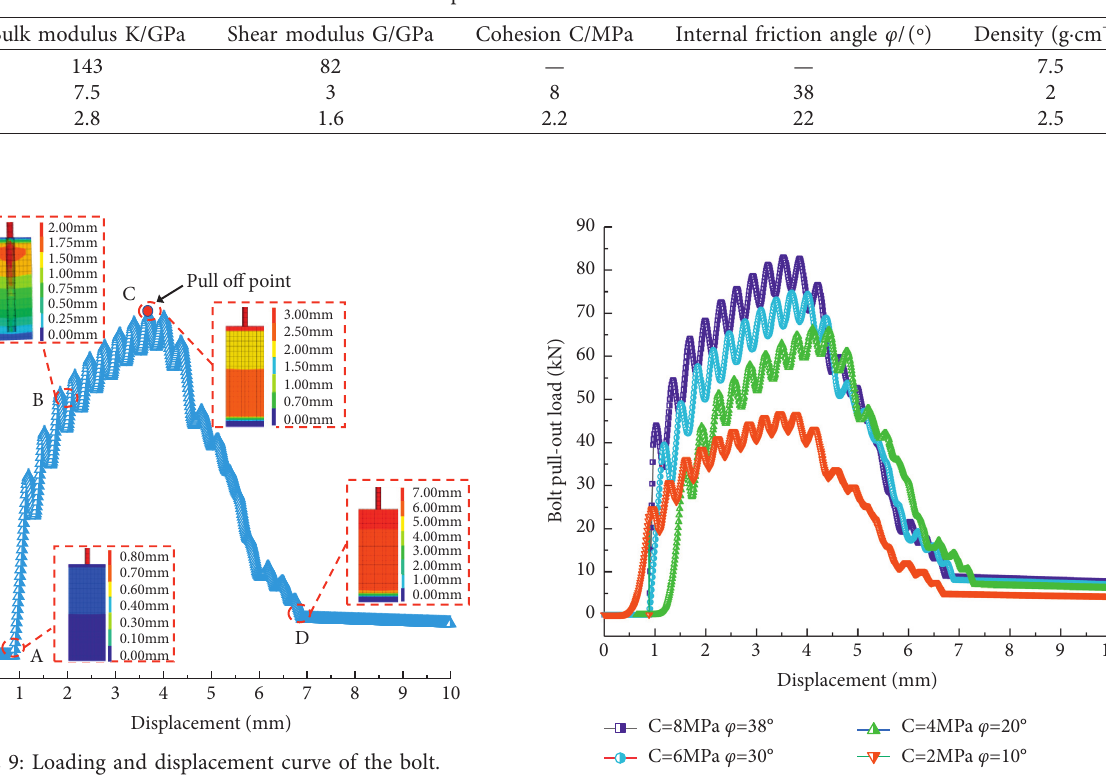
Figure 8: Numerical calculation model. Table 2: Mechanical parameters of simulated materials.